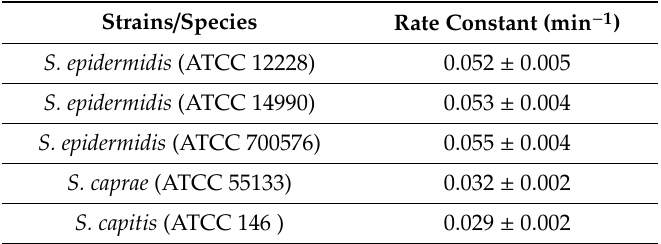
Table 1. Lytic activity of the catalytic MurNac-LAA domain towards di ff erent S. epidermidis strains and Staphylococcus